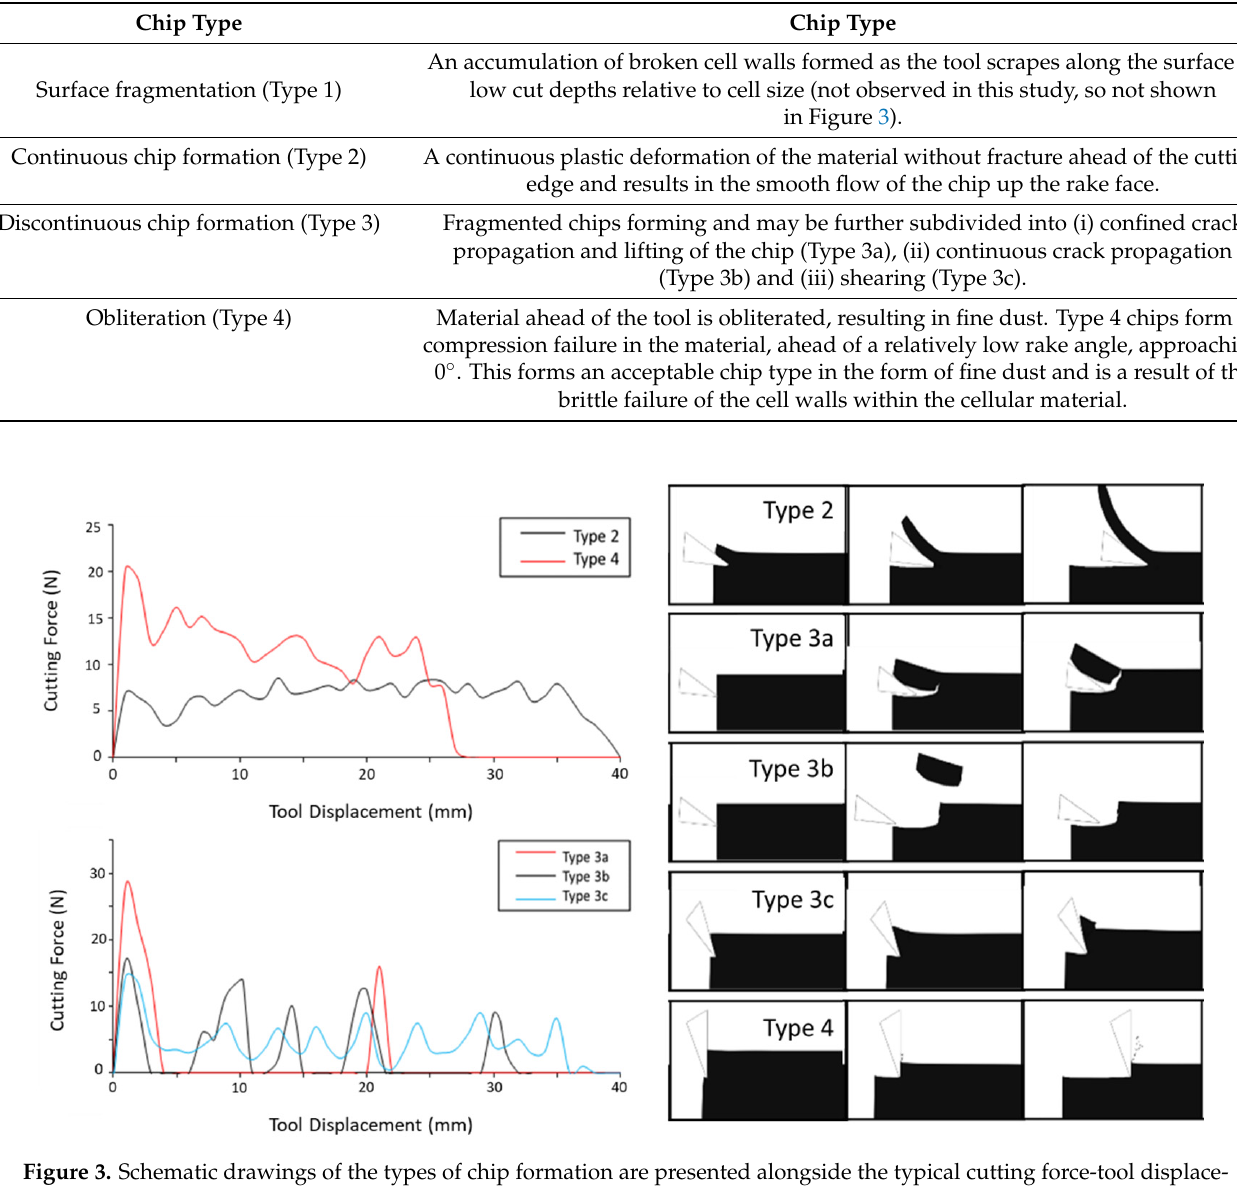
Figure 4. Nominal stress-nominal strain curves for PU20 obtained from dynamic uniaxial compres- sion testing at high strain rates. Table 5. Experimentally measured material properties for PU20 under uniaxial compression at two strain rates (0.1 s − 1 and 10 s − 1 ). Results are reported as mean ± SD (range). Johnson–Cook plasticity model material parameters for PU20. Young’s Modulus, E (MPa) Yield Stress (MPa)